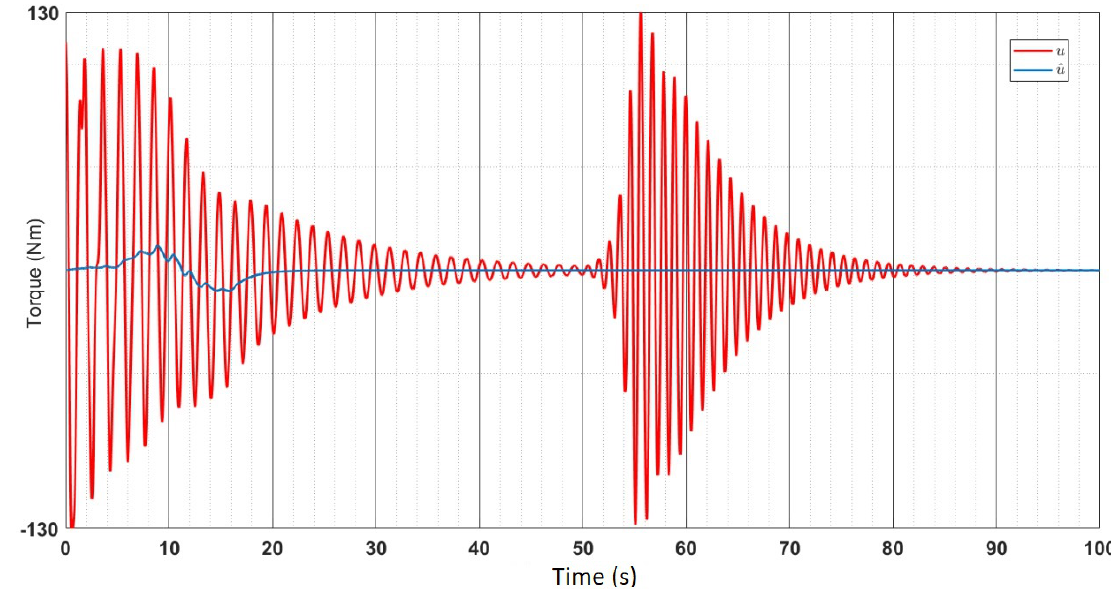
Figure 23. Comparing stabilized input and Adaptive Control